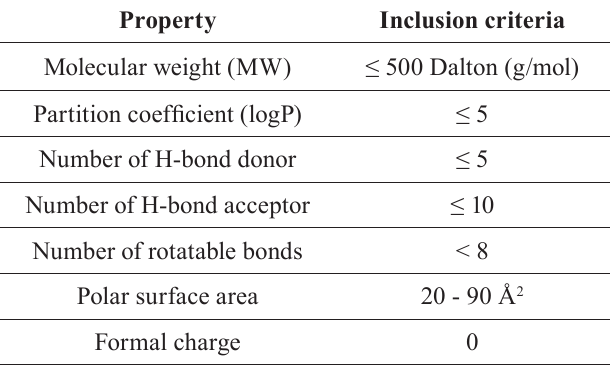
TABLE I - I nclusion criteria for CNS penetration properties (Banks, 2009; Mikitsh, Chacko, 2014; Pajouhesh,